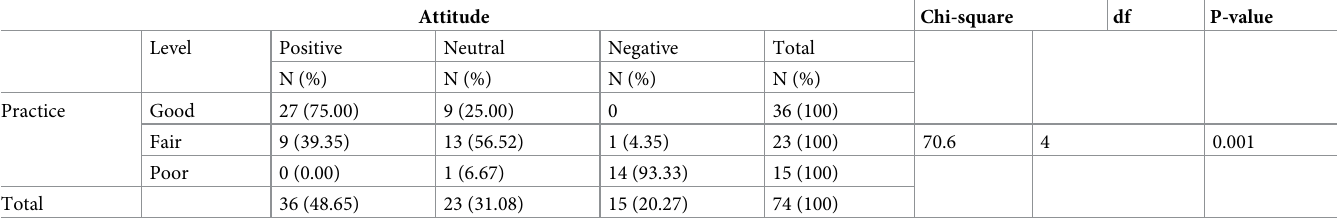
Table 10. Association between attitudes and practices of the farmer on the factors contributing to the occurrence of AMR in dairy cows and personnel.